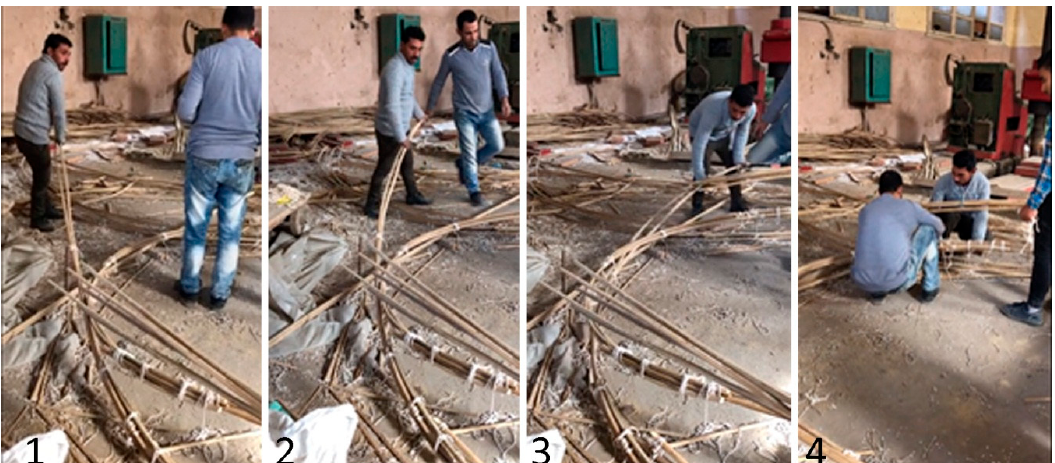
Figure 11. Steps of bending the middle bundle. ( 1 ) The first half of the middle bundle, made from 2 midribs, is fixed to the bottom bundle by ropes. ( 2 ) The middle bundle is bent by a moving worker. ( 3 ) Completing the bending of the middle bundle. ( 4 ) Fixing the ending of the middle bundle to the opposing bottom bundle.